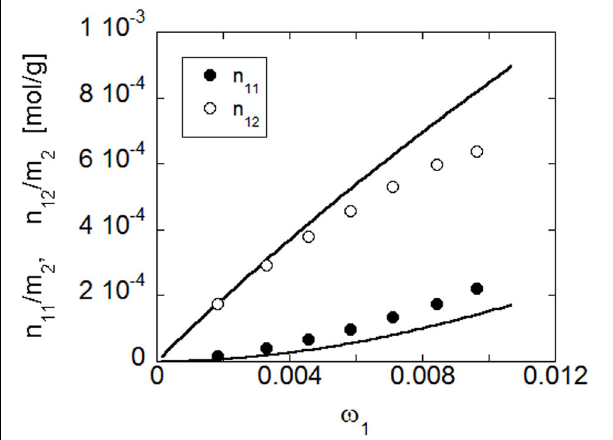
FIGURE 15 | Comparison of predictions of NETGP-NRHB model with experimental results for PEI at 30 ◦ C. Data and model predictions are reported as a function of water mass fraction in terms of moles of water self-hydrogen bonding in the polymer/water mixture per gram of dry poly- mer as a function of water mass fraction, n 11 / m 2 , and moles of hydrogen bonding between absorbed water molecules and proton acceptor groups on the polymer backbone in the polymer/water mixture per gram of dry polymer, n 12 / m 2 (experimental points were evaluated from spectroscopic results assuming a 1:2 stoichiometry of water/carbonyl